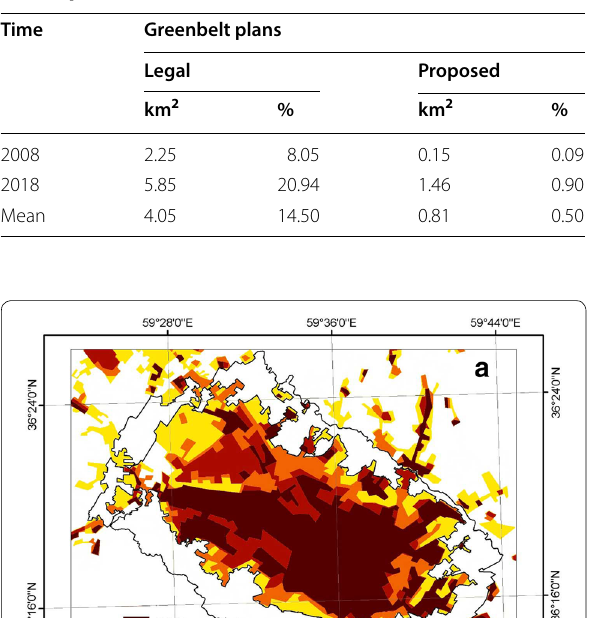
Table 4 Occupation rate of sprawl expansion inside of greenbelt plans based on past and present status of urban development